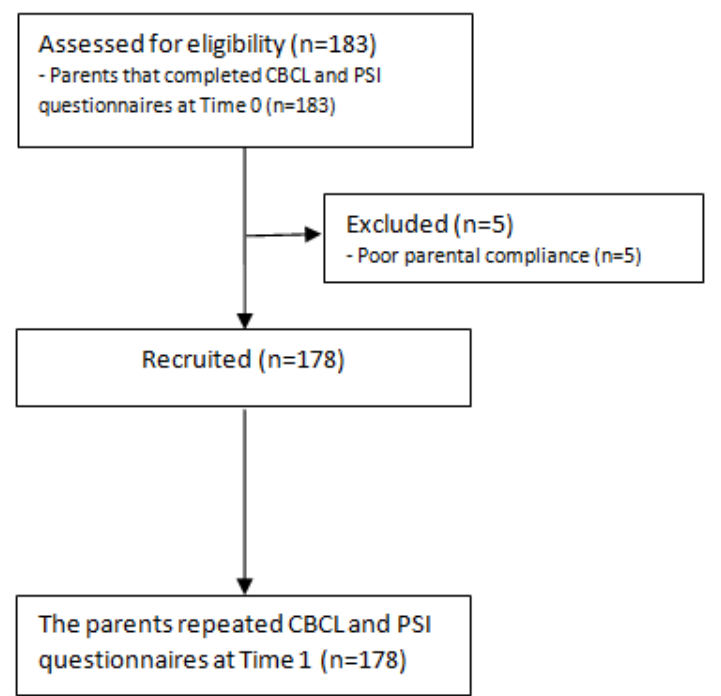
Figure 1. Flow-chart of the research procedure. CBCL, Child Behavior Check List; PSI, Parenting